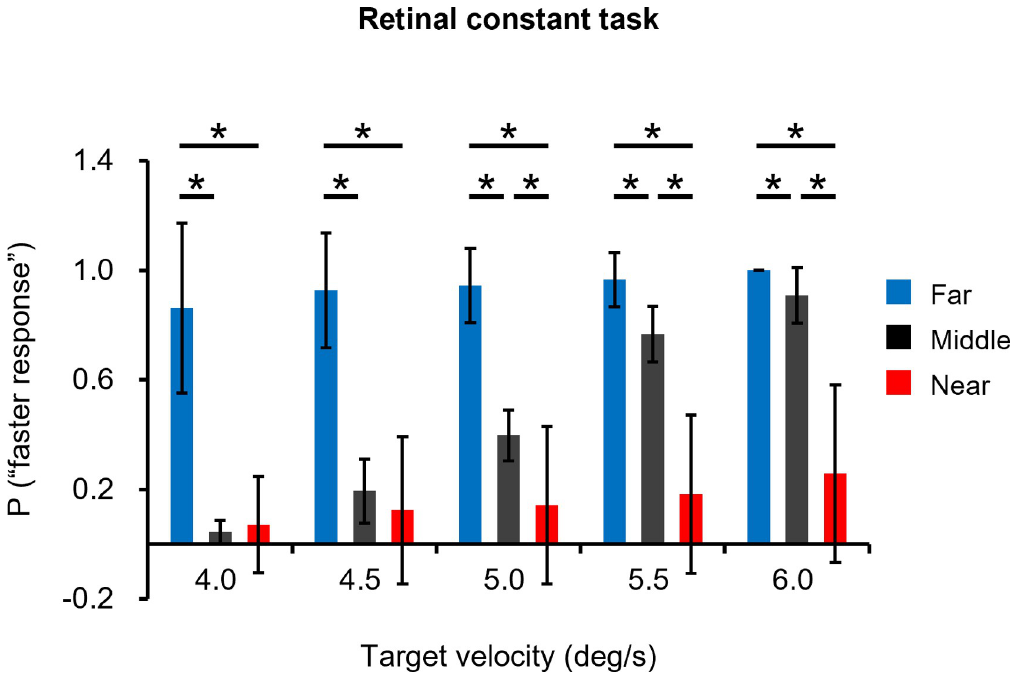
of the far, middle and near conditions at target velocities of 5.0, 5.5 and 6.0 deg/s (all p ’s < 0.05). These results indicate that visual target speed is perceived faster in order of the far, middle and near conditions.